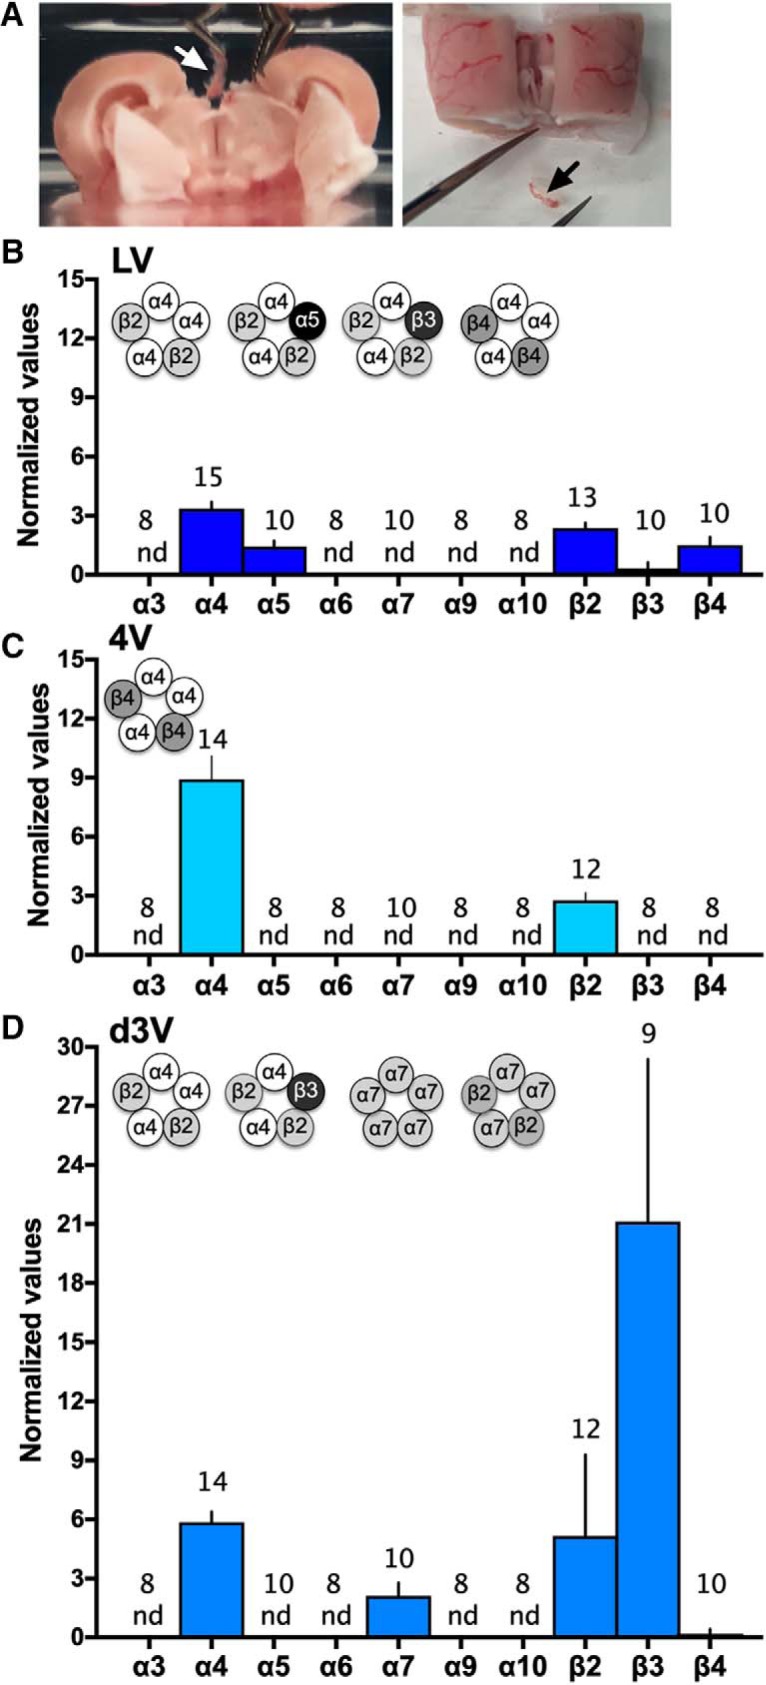
nAChR subunit expression in choroid plexus derived from the lateral, fourth, and d3Vs. Choroid plexus was discretely dissected from the ventricles of the brain. A, The outer layer of cortex and hippocampus were gently separated from the midline to allow for visualization and removal of the d3V choroid plexus with visualization via dissection microscope (left image with white arrow), and following removal, the choroid plexus was clearly visualized as completely separate from brain tissue (right image with black arrow). Similar dissections were conducted with microscopic visualization and verification for the lateral and fourth ventricle locations. B–D, The expression of nAChR subunits was examined in choroid plexus tissue from rats (n = 8–15/group, specific number per group denoted on each bar). B, In the lateral ventricle (LV), mRNA expression was found for the α4 (Chrna4), α5 (Chrna5), β2 (Chrnb2), β3 (Chrnb3), and β4 (Chrnb4) nAChR subunits. Putative nAChR subtype schematics are graphically illustrated (insert). Statistical data are as follows [central tendency (mean) ± variation (SEM), lower 95% confidence interval, upper 95% confidence interval]: α4: 3.35 ± 0.34, 2.61, 4.09; α5: 1.44 ± 0.29, 0.77, 2.10; β2: 2.37 ± 0.28, 1.77, 2.97; β3: 0.32 ± 0.32, 0, 1.03; and β4: 1.50 ± 0.42, 0.56, 2.45. C, In the fourth ventricle (4V), only α4 (Chrna4) and β2 (Chrnb2) mRNAs were detected, and thus, the α4β2 nAChR subtype may be present (schematic insert). Statistical data are (mean ± SEM, lower CI, upper CI): α4: 8.93 ± 1.18, 6.38, 11.47 and β2: 2.77 ± 0.38, 1.93, 3.61. D, In the d3V, subunit expression consisted of α4 (Chrna4), α7 (Chrna7), β2 (Chrnb2), and β3 (Chrnb3), which allows for four different putative nAChR subtypes (schematic insert). Statistical data are (mean ± SEM, lower CI, upper CI): α4: 5.86 ± 0.53, 4.71, 7.01; α7: 2.12 ± 0.67, 0.61, 3.62; β2: 5.16 ± 1.19, 2.53, 7.79; and β: 21.12 ± 8.25, 2.09, 40.14. For each nAChR gene above, expression data were normalized to expression of β-actin as the endogenous control. nd = not detected based on the predetermined RT-qPCR criteria (Ct value > 35). Data represent mean normalized values ± SEM.